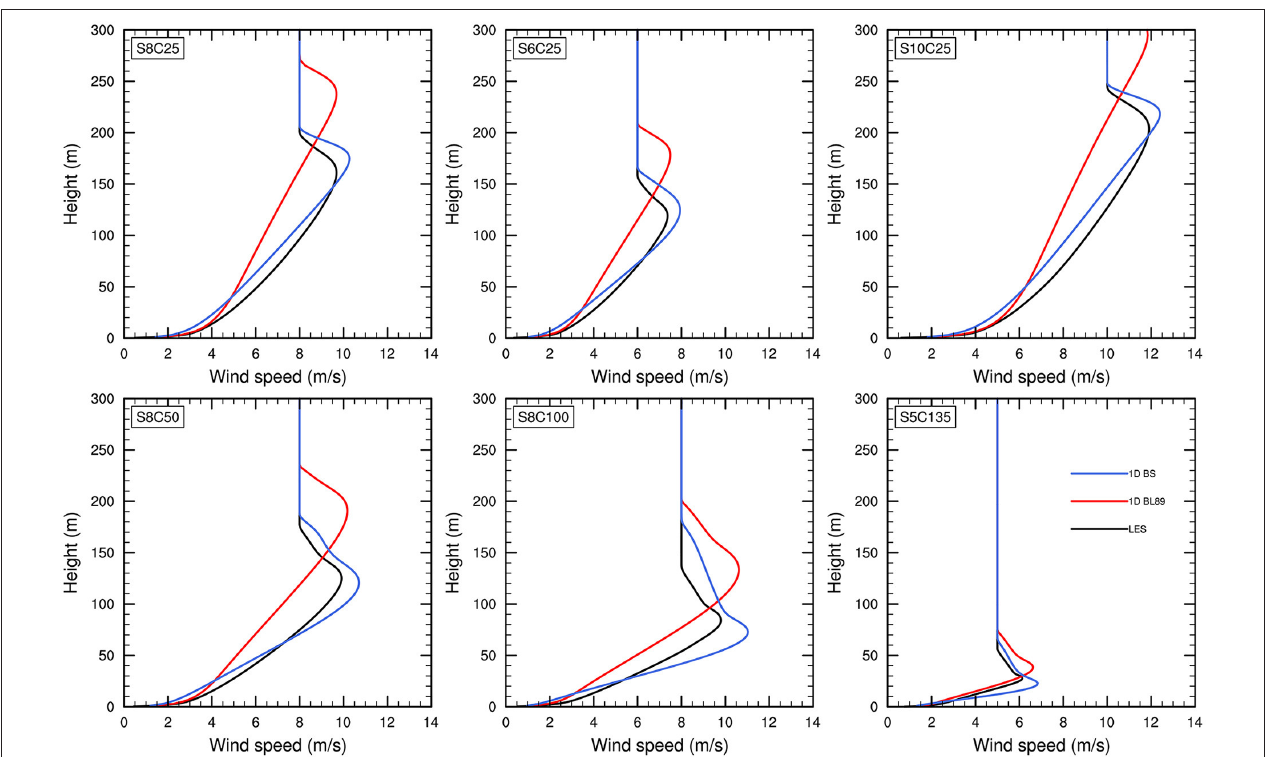
FIGURE 7 | Wind speed profiles averaged over the final hour (8–9thh) for the stably stratified cases (S8C25, S8C50, S8C100, S5C135, S6C25, and S10C25; see Table 1 ) for the LESs (black), the SCMs with the BL89 length (red), and the SCMs with the BS length (blue).